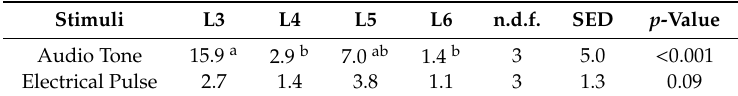
Table 5. Predicted mean stimuli and total number of stimuli delivered within locations 3 to 6 for grazing allocation 1. a,b Indicates significant di ff erence in mean number of audio tones delivered between locations.